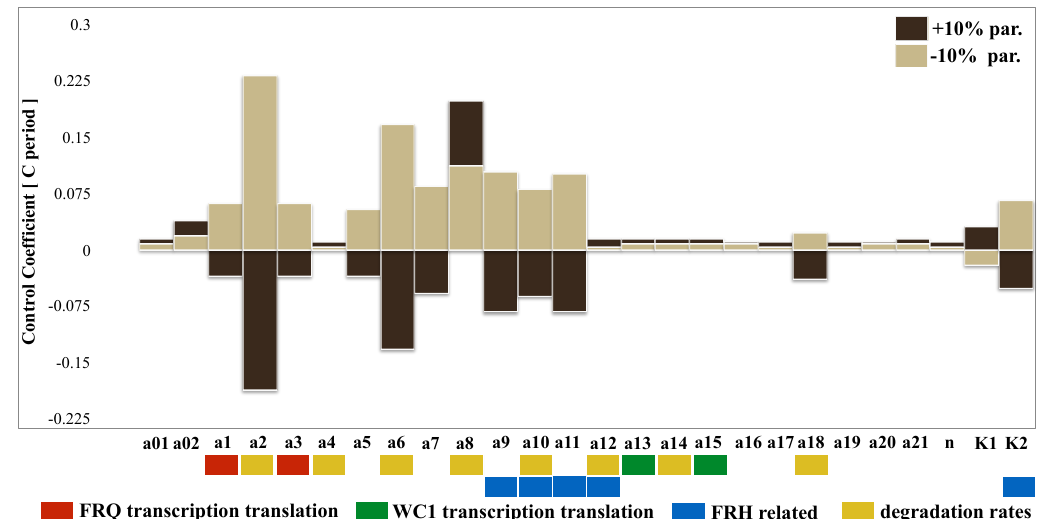
Figure A6. Sensitivity analysis after clamping the positive feedback: All parameters were changed by ± 10 percent, and the resulting periods were calculated. Positive and negative period control coefficients indicate period lengthening and shortening, respectively (compare Figure 6).